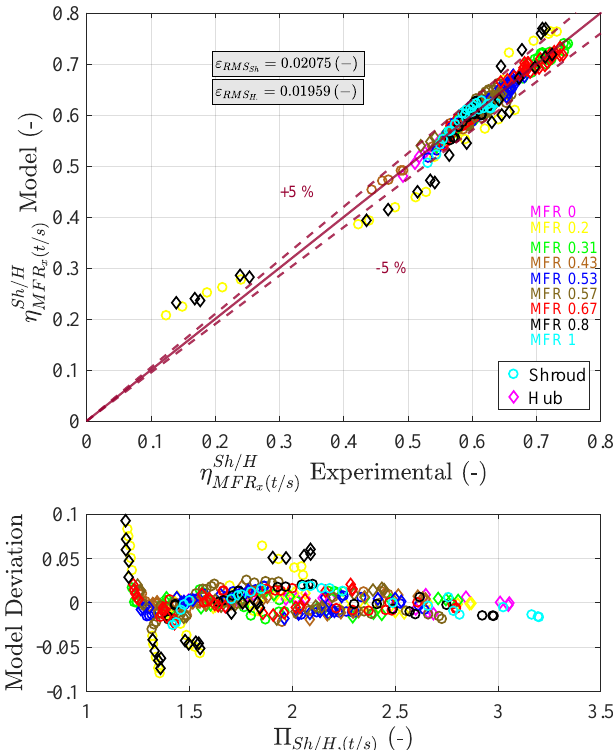
Figure 16. Comparing the apparent turbine efficiency results from VGT turbine model with the experimental values for T#1TE turbocharger. Each MFR map is individually fitted for the respective turbine